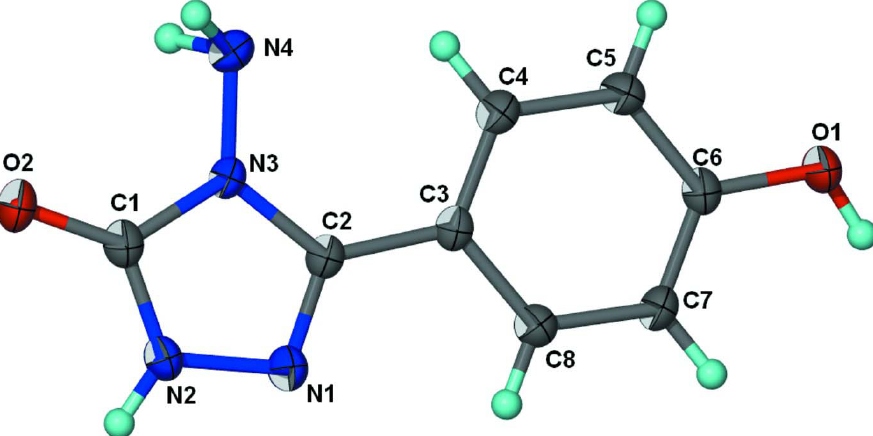
Thermal ellipsoid (Barbour, 2001) plot of C